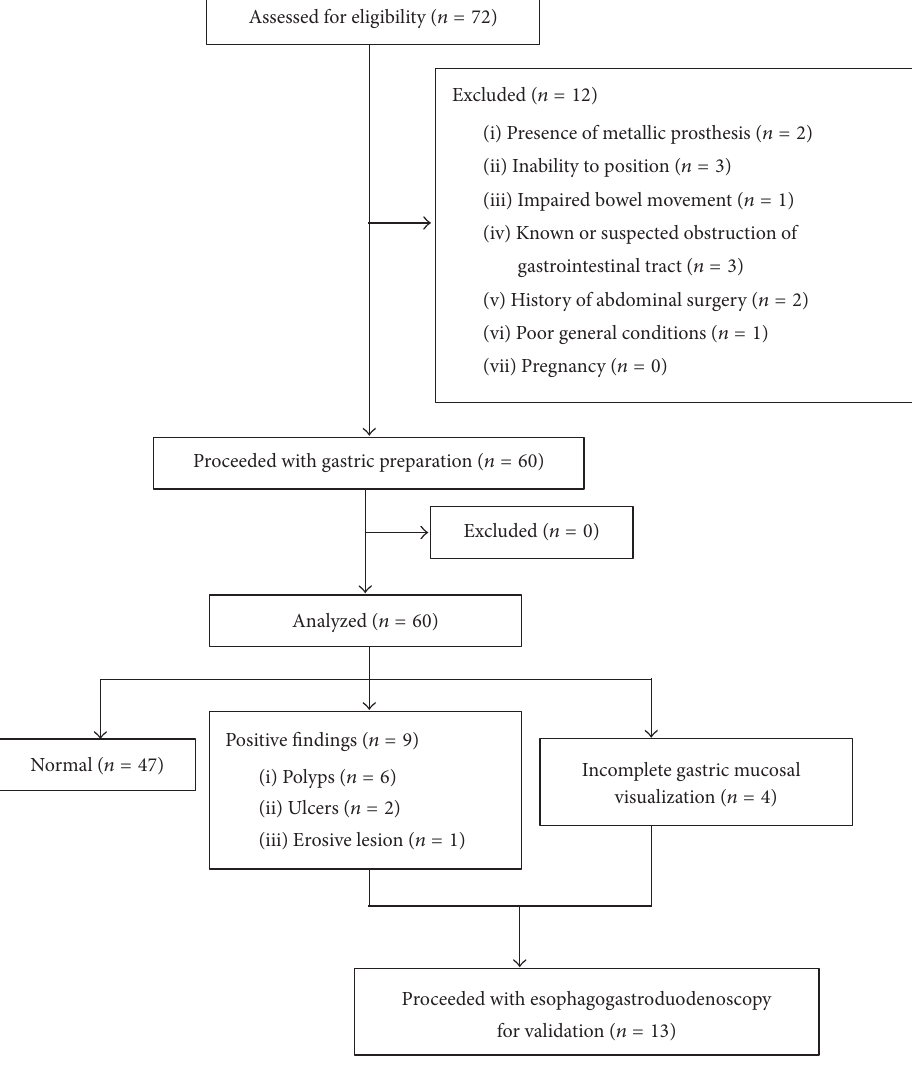
Figure 1: Flow chart of the